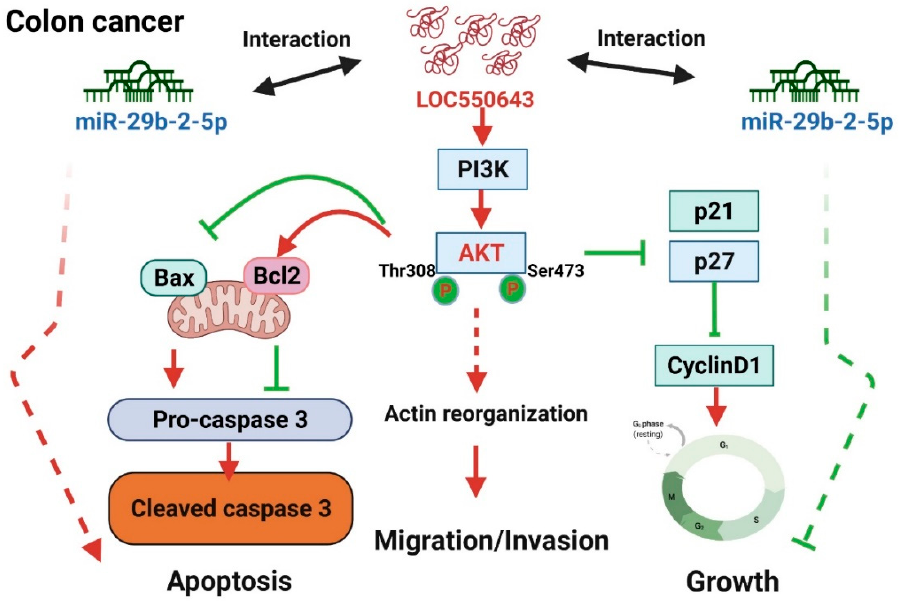
Figure 9. The proposed model for the mechanistic LOC550643 regulation of colon cancer cell growth, apoptosis and metastasis through modulation of PI3K signaling activation and the LOC550643-miR-29b-2-5p axis.